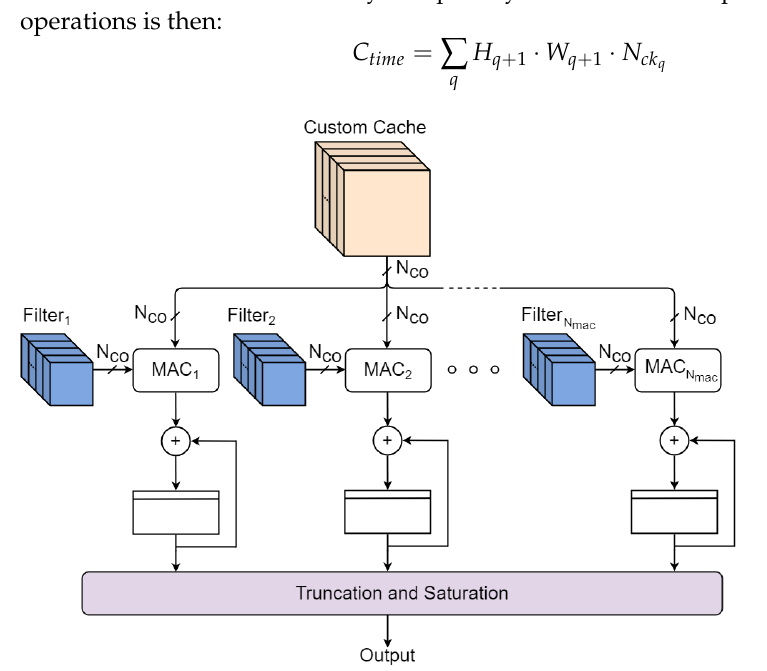
Figure 4. Shared Convolutional Layer